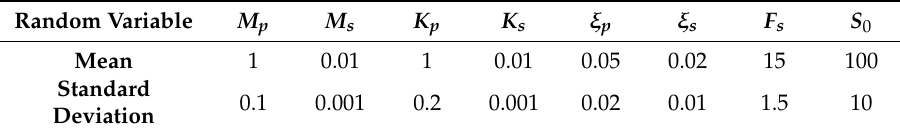
Figure 9. Two-degrees of freedom dynamic system. Table 6. Statistics of random variables in Example 5.